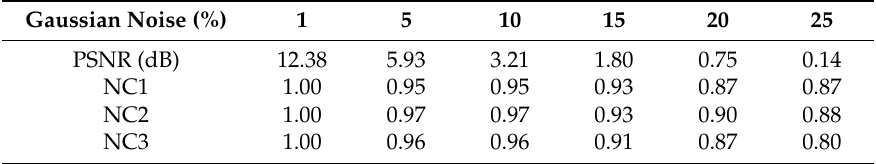
Table 3. Data of Gaussian noise attacks.